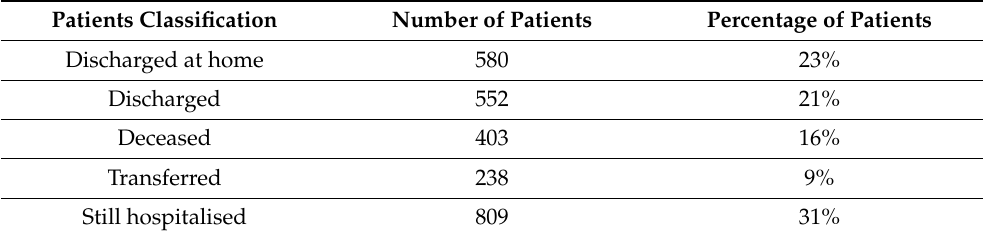
Table 5. COVID-19 patients at the Spedali Civili Hospital in Brescia as of 2 April, 2020, split by patients in home isolation and those hospitalised. Hospitalised patients may be further divided into discharged, deceased, transferred, and still-hospitalised patients.